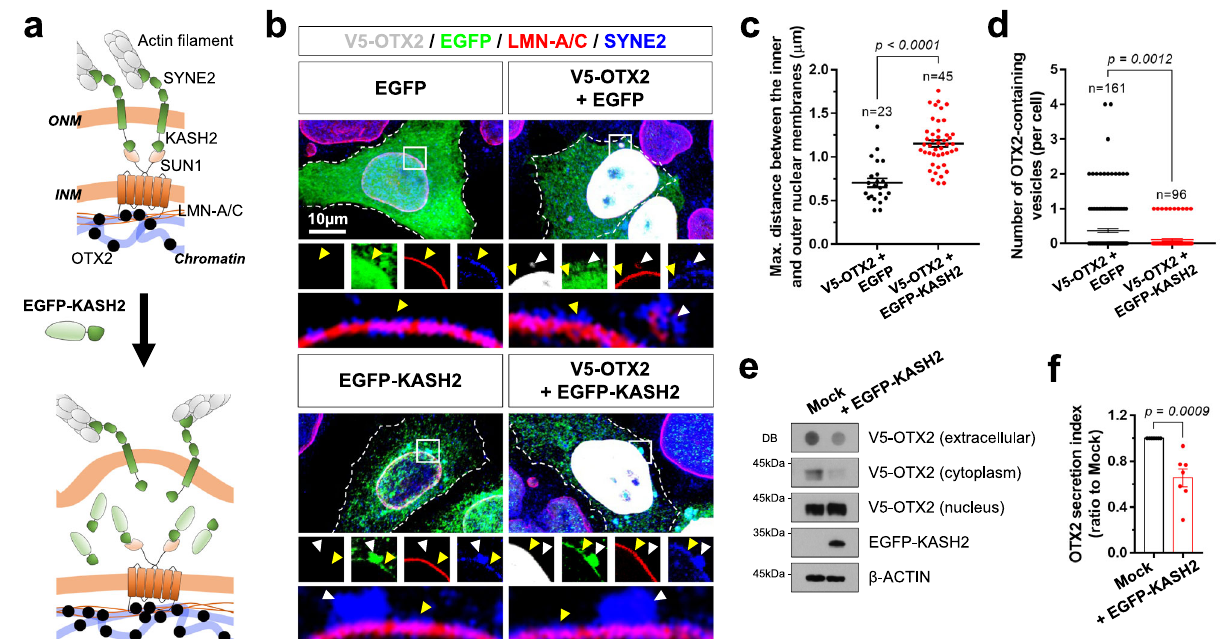
Fig. 7 | OTX2 secretion is suppressed upon disruption of the LINC complex. a Schematic diagram that shows the disruption of LINC complex by EGFP-KASH2. b HeLa cells overexpressing V5-OTX2 together with EGFP or EGFP-KASH2 were stainedwithantibodiesdetectingV5,EGFP,LMN-A/C,andSYNE2.Whiteandyellow arrowheads indicate fl at and bulged areas of the nuclear envelope, respectively. A dot in the graphs represents the maximum (Max.) distance between the inner and outer nuclear membranes ( c ) and the number of OTX2-containing perinuclearand cytoplasmicvesicles( d )inacell.Longsidebarsindicatemeanvaluesanderrorbars denote SEM obtained from 6 independent experiments. The numbers of cells